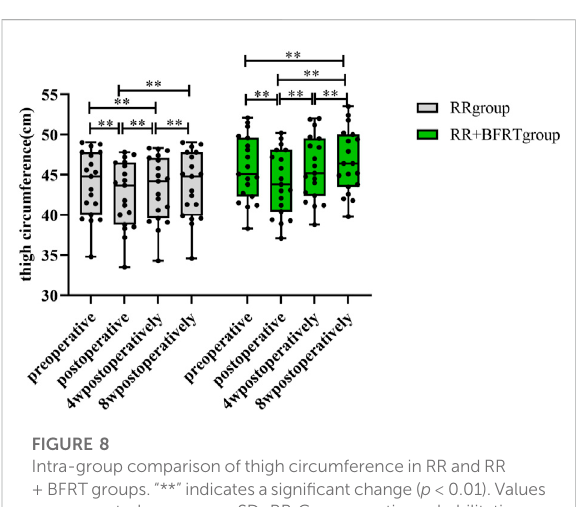
FIGURE 8 Intra-group comparison of thigh circumference inRR and RR +BFRTgroups. “ ** ” indicatesasigni fi cantchange( p < 0.01).Values are presented as mean ± SD. RR Group: routine rehabilitation group; RR + BFRT Group: routine rehabilitation + blood fl ow restriction training group.